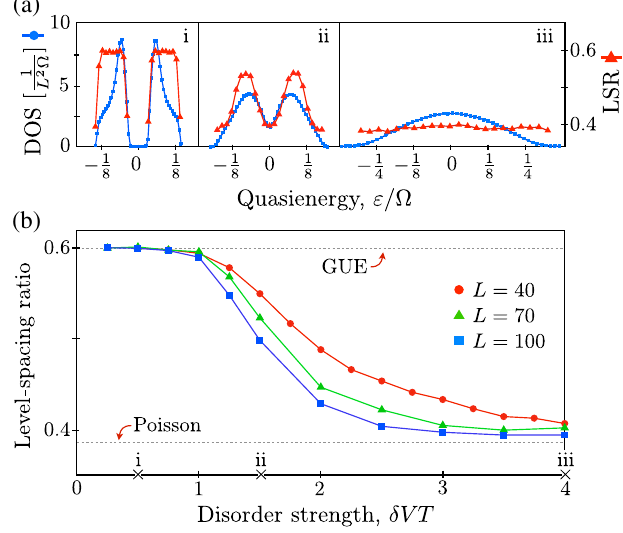
FIG. 4. Localization of Floquet states in the AFAI as a function of disorder strength, computed for the model presented in Eq. (17). We use λ ¼ π and an L × L system with periodic boundary conditions. (a) Quasienergy density of Floquet states per unit area (DOS) and level-spacing ratio (LSR), for three values of disorder strength, as indicated by the markers on the axis of (b). For all cases we take L ¼ 70 . (b) Finite-size scaling of the localization transition. Level statistics in the delocalized regime are described by the Gaussian unitary ensemble (GUE), characterized by an average level-spacing ratio r ≈ 0 . 60 ; in the localized regime, Poissonian level statistics ext ≈ 0 . 39 . These characteristic values are indicated by give r loc dashed